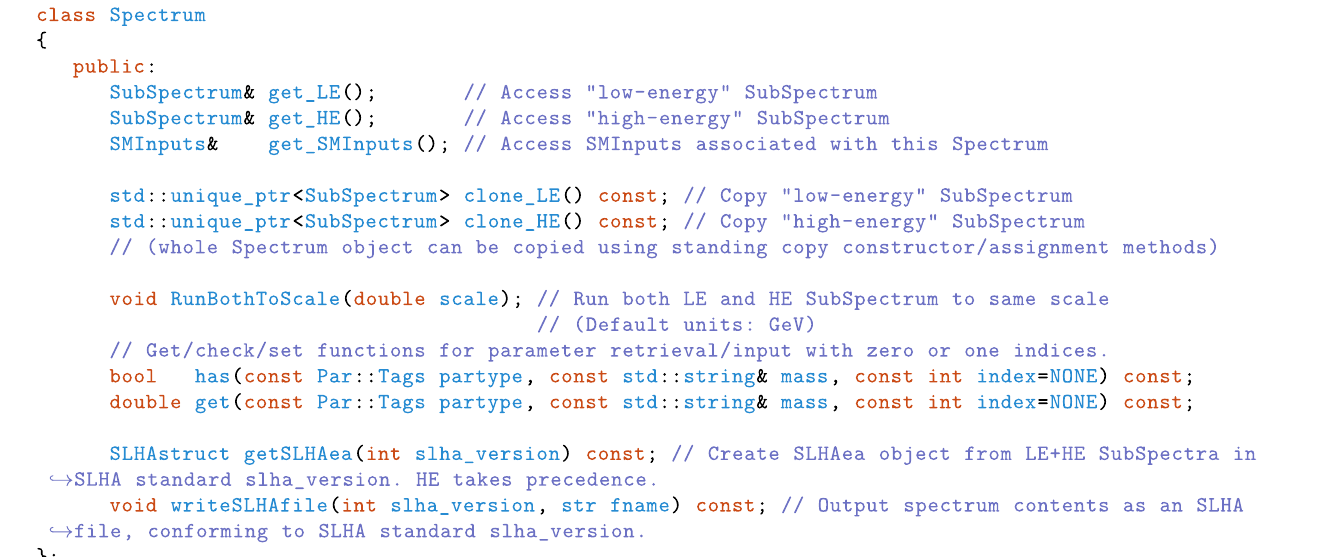
Fig. 4 Simplified class declaration of primary Spectrum